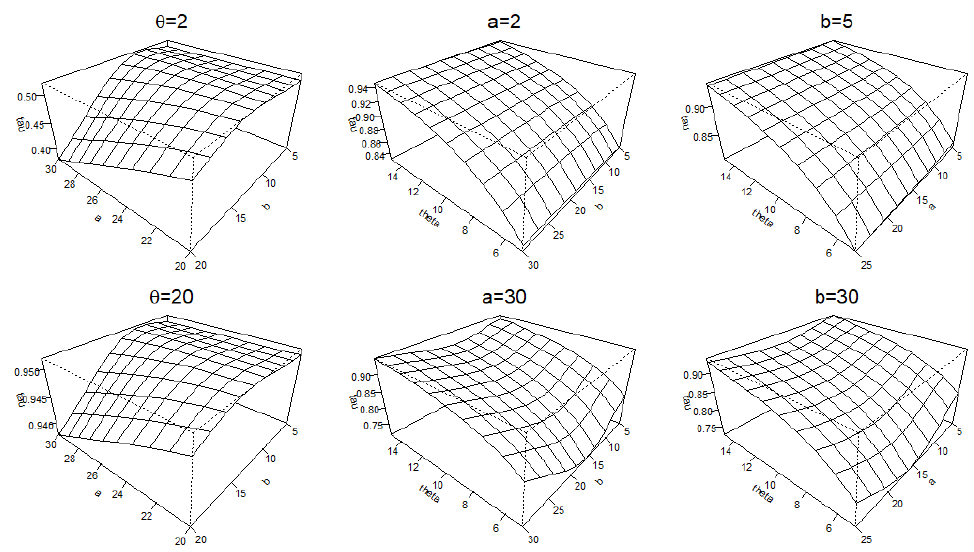
Figure 2. Kendall’s-tau surface plot for the UL-Gumbel copula for various parameter values.